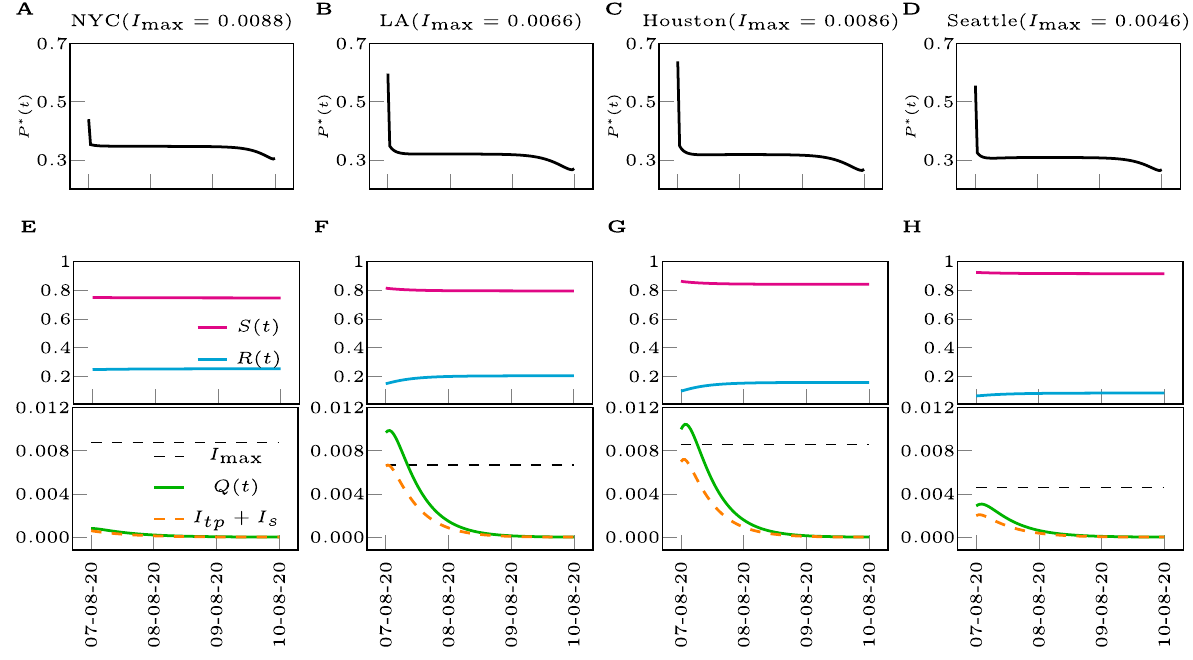
Figure 3. Optimal control solutions for different Metropolitan Statistical Areas within the US. ( A – D ) Optimal control inputs for the metropolitan cities of NYC, LA, Houston, Seattle (from left to right). ( E – H ) Time evolution of the states subject to the optimal control inputs. I max are chosen as the minimum of the range in Table 3 ( ρ = 2 / 3 ) and c p = c q = 1 . The legends in ( F – H ) are same as the legend in ( E